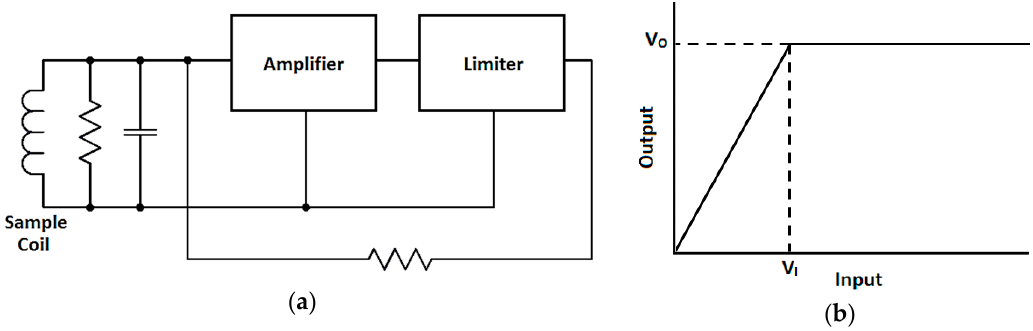
Figure 9. ( a ) Limited self-oscillator; ( b ) Ideal characteristics of the limiter.